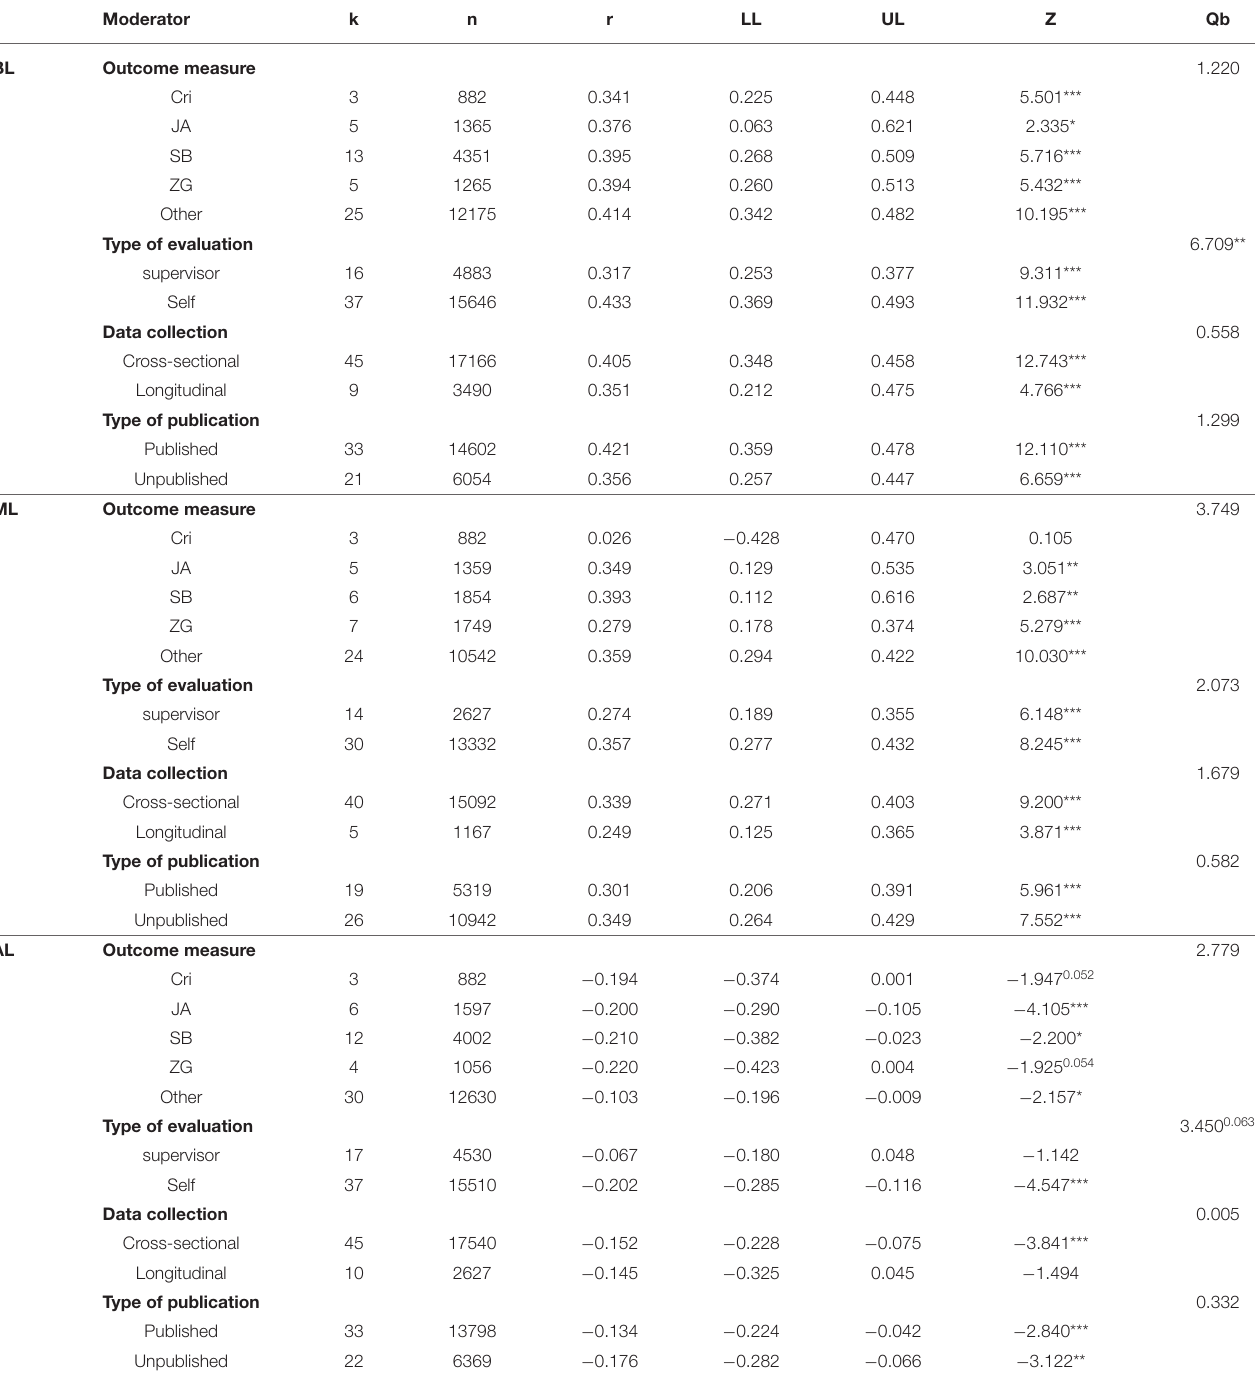
TABLE 5 | Moderating effects of categorical variables (subgroup